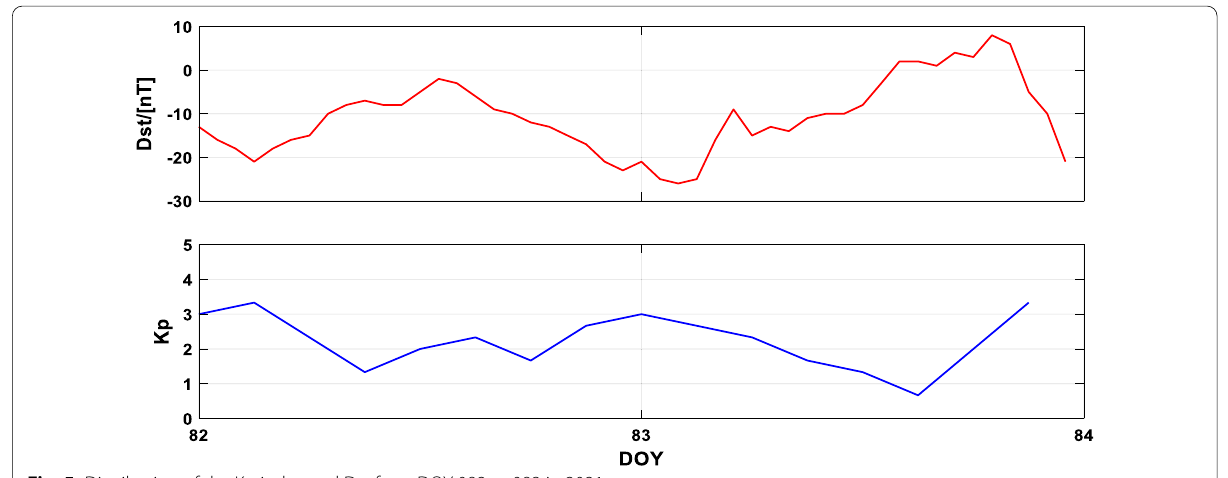
Fig. 5 Distribution of the Kp index and Dst from DOY 082 to 083 in 2021